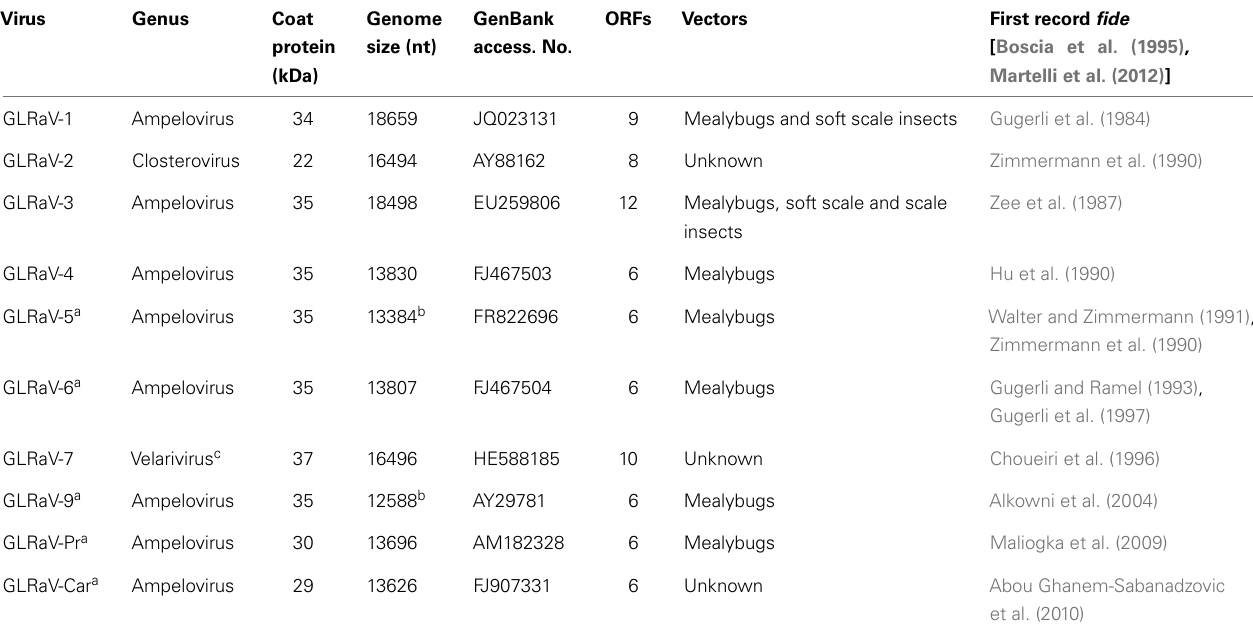
Table 1 | Current classification and some properties of Grapevine leafroll-associated viruses